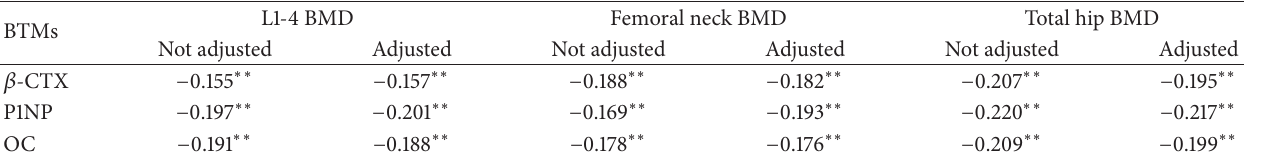
) between BTMS and BMD in 520 postmenopausal std